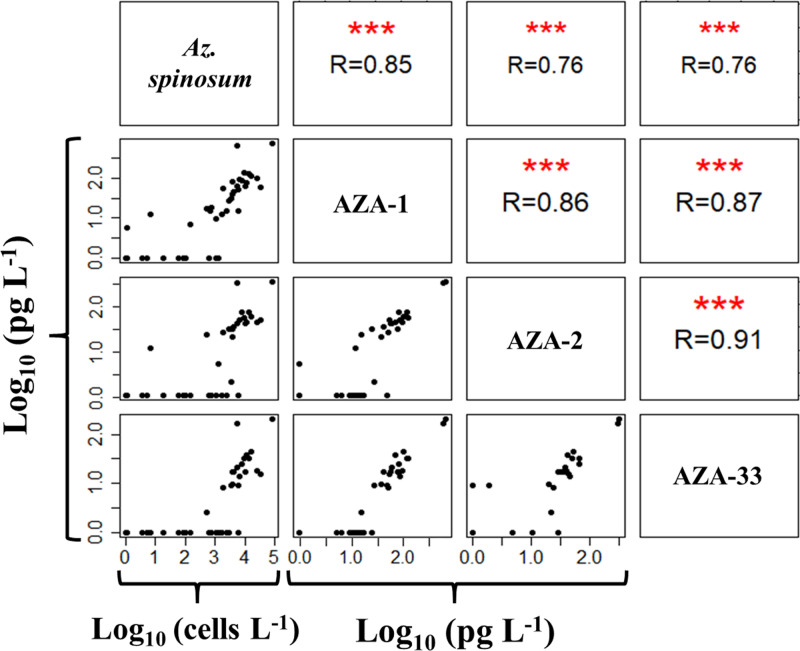
Pearson correlation matrix of logarithmic qPCR counts (cells L-1) and logarithmic AZA quantities (pg L-1).“R” displays the respective correlation coefficient. Significance levels of respective correlations (Pearson's product-moment correlation test) are indicated by red asterisks (* p ≤ 0.05, ** p ≤ 0.01, *** p ≤ 0.001).